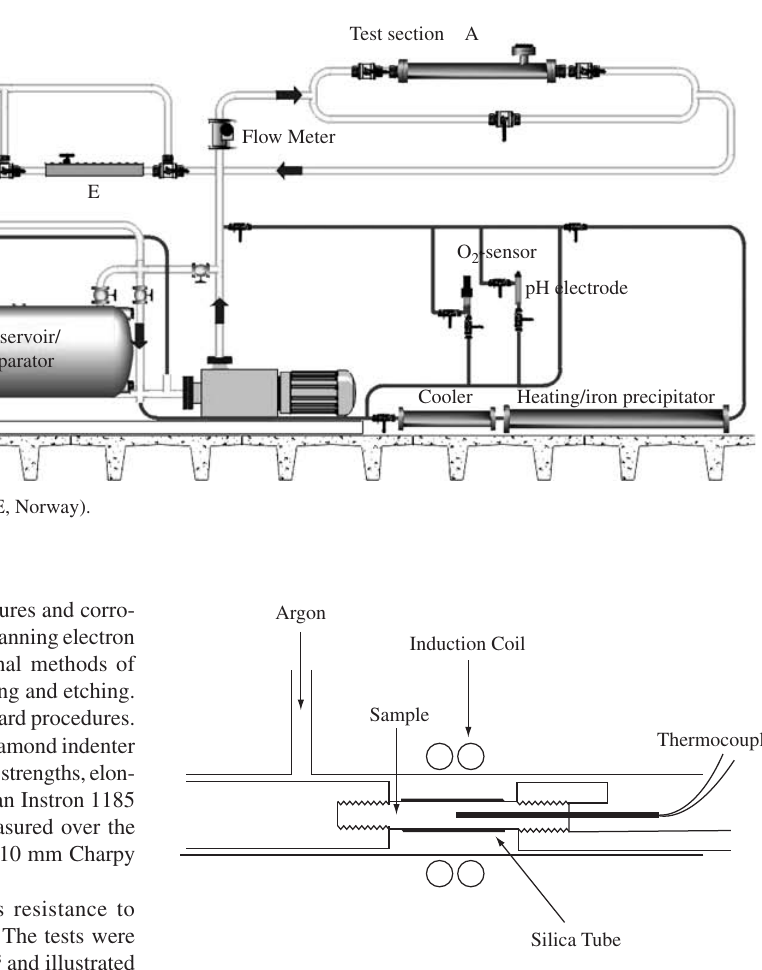
Figure 3. Schematic diagram of the apparatus used for hot ductility testing. (Courtesy of B. Mintz, City University,